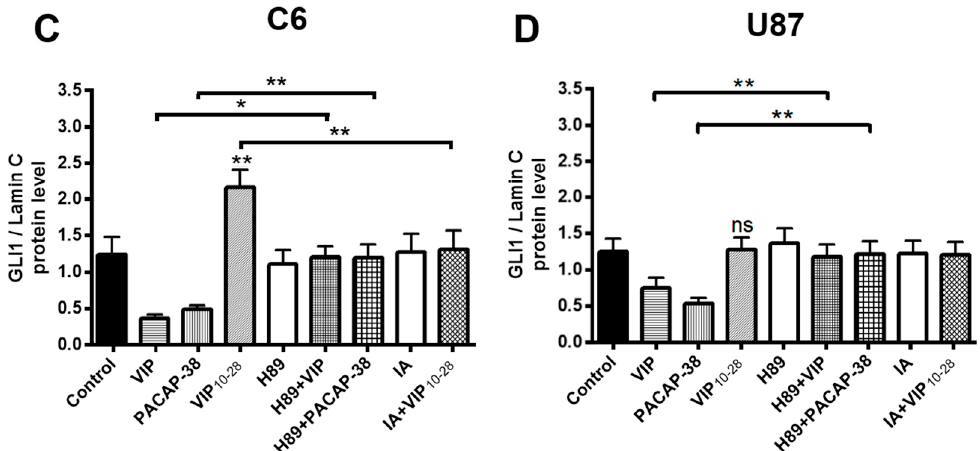
Figure 4. Effects of VIP, PACAP-38, VIP 10-28 , and/or inhibitors H89 (PKA inhibitor), IA (Akt inhibitor) on the expression and intracellular localization of GLI1 protein in C6 and U87 cells. ( A ) Western immunoblotting of GLI1 proteins in C6 and U87 cells. Cytosolic and nuclear proteins of cells were resolved by SDS-PAGE, transferred to membranes, and further probed with antibody anti-GLI1, anti-GAPDH, or anti-Lamin-C. GAPDH and Lamin-C proteins are used as a control for cytosolic and nuclear extracts, respectively. ( B ) Western immunoblotting of GLI1 proteins in C6 and U87 cells treated or not with neuropeptides in absence or presence of pathways inhibitors. Nuclear proteins were extracted from cells treated or not with neuropeptides at 10 − 7 M for 24 h. Cells were incubated for 20 min with an inhibitor (1 µ M of H89 or IA) followed by treatment with VIP, PACAP-38, or VIP 10-28 at 10 − 7 M for 24 h. Nuclear proteins of cells were resolved by SDS-PAGE, transferred to membranes and further probed with antibody anti-GLI1 or anti-Lamin-C. ( C , D ) Cumulative data from three independent experiments, in same conditions as in ( B ), after densitometry quantification of immunoblotting (WB) data. Quantification data are the mean ± SD. Data were analyzed using the Kruskal–Wallis test and Dunn’s post hoc test (* p < 0.05 and ** p < 0.01, ns: not significant).